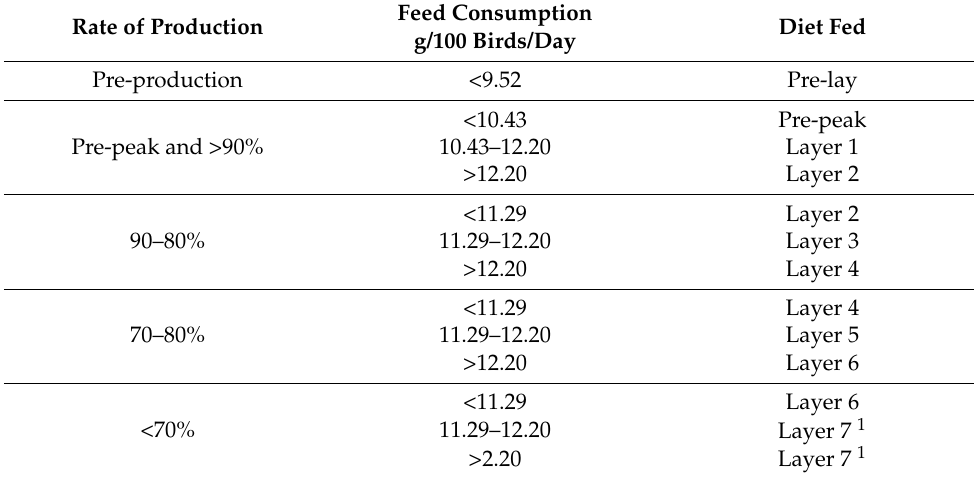
Table 1. Feeding program of diets according to egg production rate and ad libitum consumption